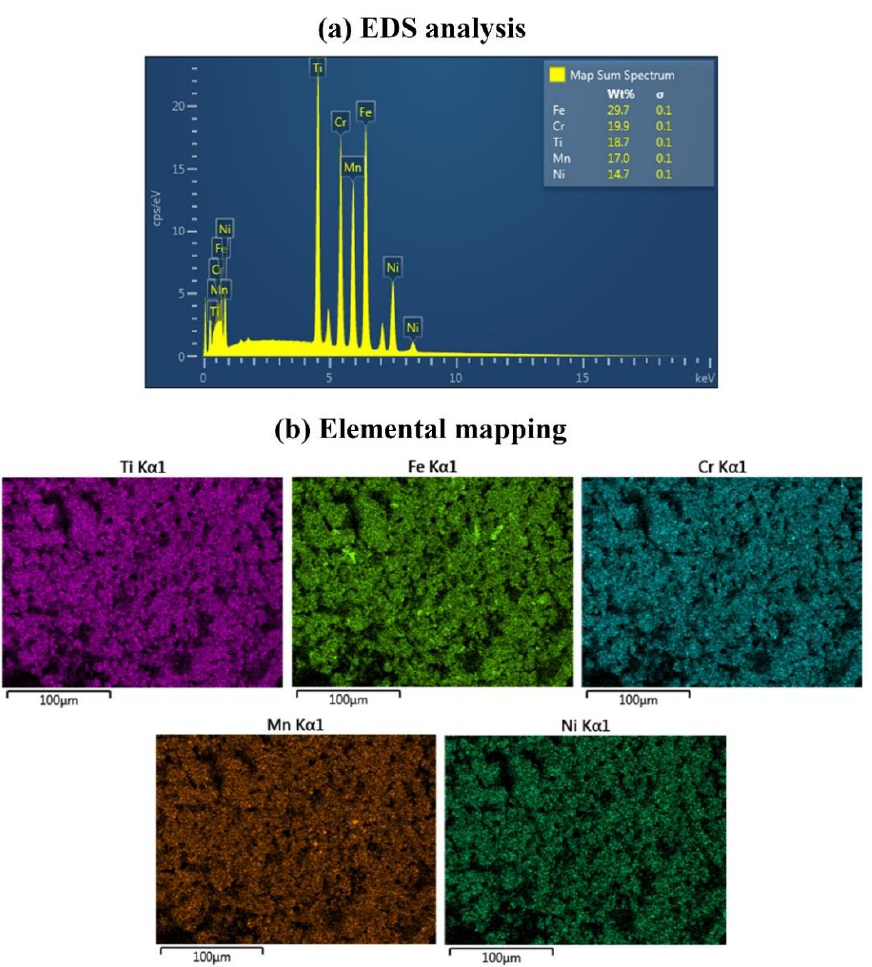
Figure 6. Elemental analysis and their distribution in 15 h ball milled HEA